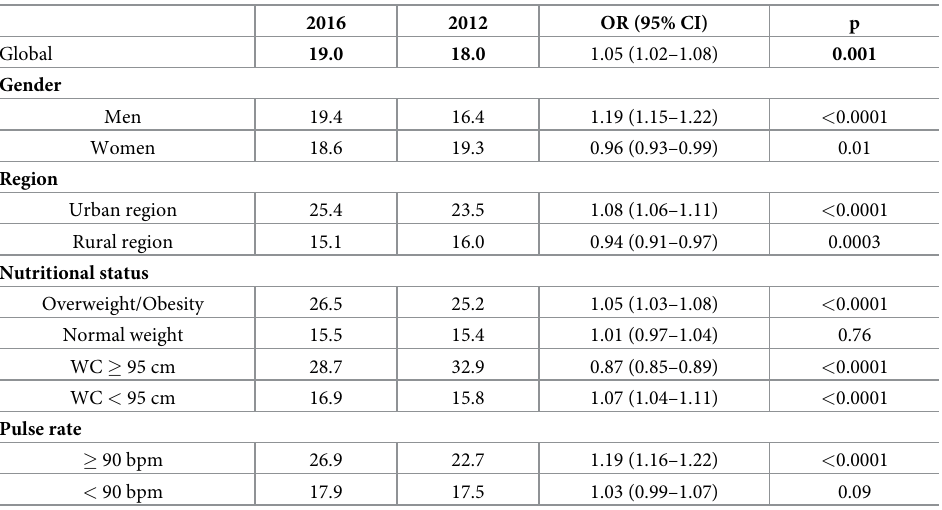
Table 5. Age standardized prevalence of hypertension.